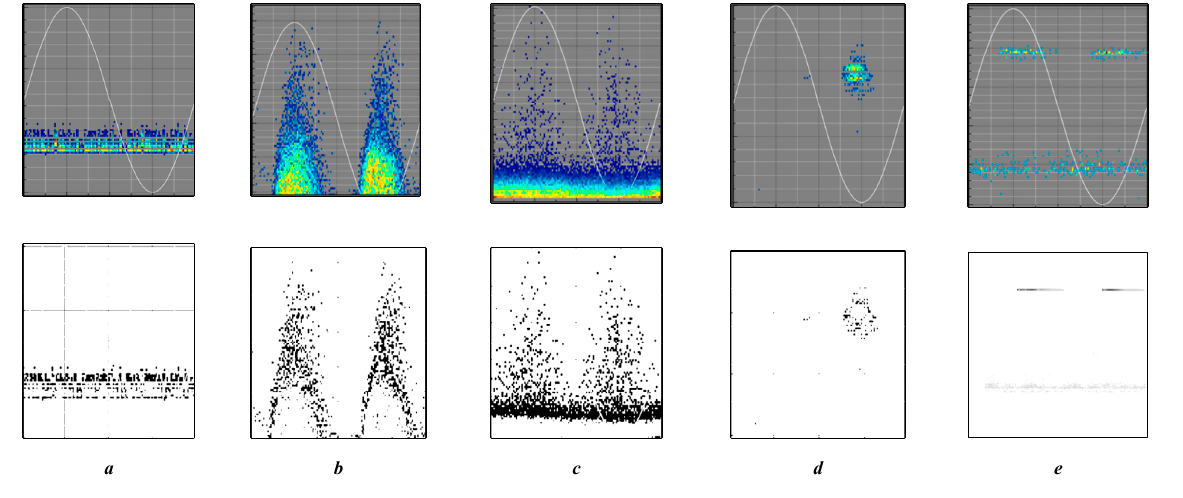
Figure 3. PRPD maps of grayness. ( a ) normal, ( b ) insulating void defects, ( c ) free metal particle defects, ( d ) metal tip defects, ( e ) floating electrode